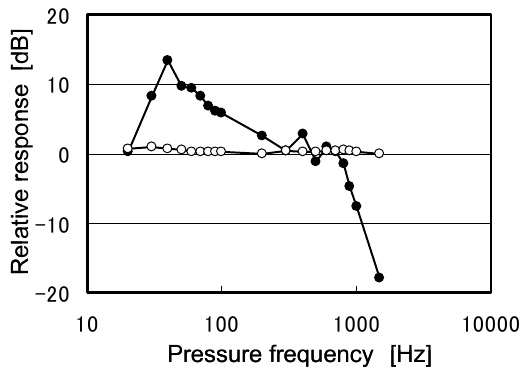
Fig. 7 Frequency response ( natural response: ● , compensated response: ○